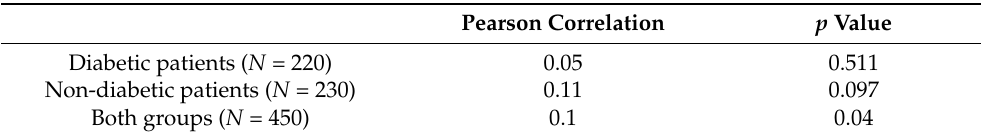
Table 3. Workload measured in stamina and correlation to days of sickness absence along 1 year of follow-up.